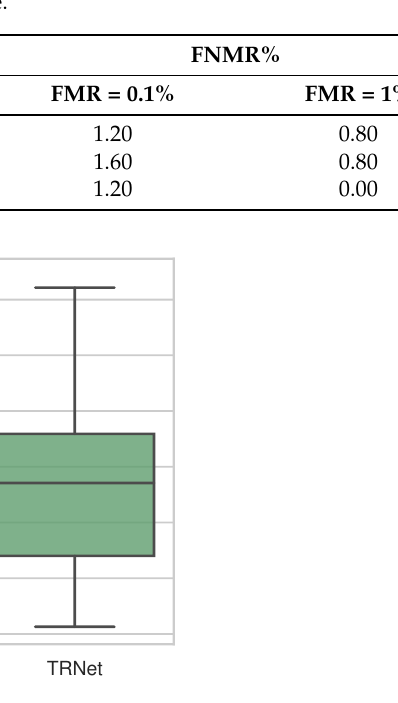
Figure 17. Boxplots showing the effect of tattoo removal on biometric comparison